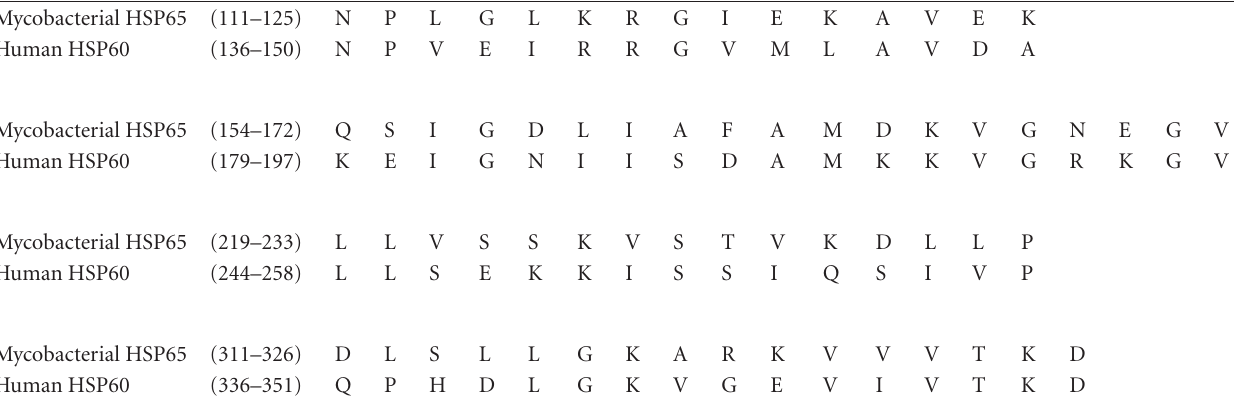
Table 2: Conserved peptide sequences of mycobacterial HSP65 and human HSP60 [20].